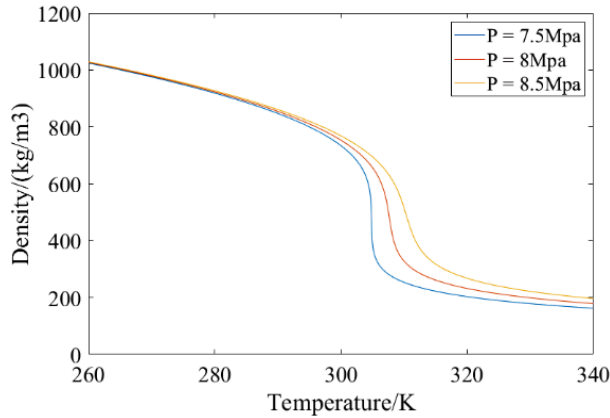
Figure 2. Density variation of CO 2 at different isobars.